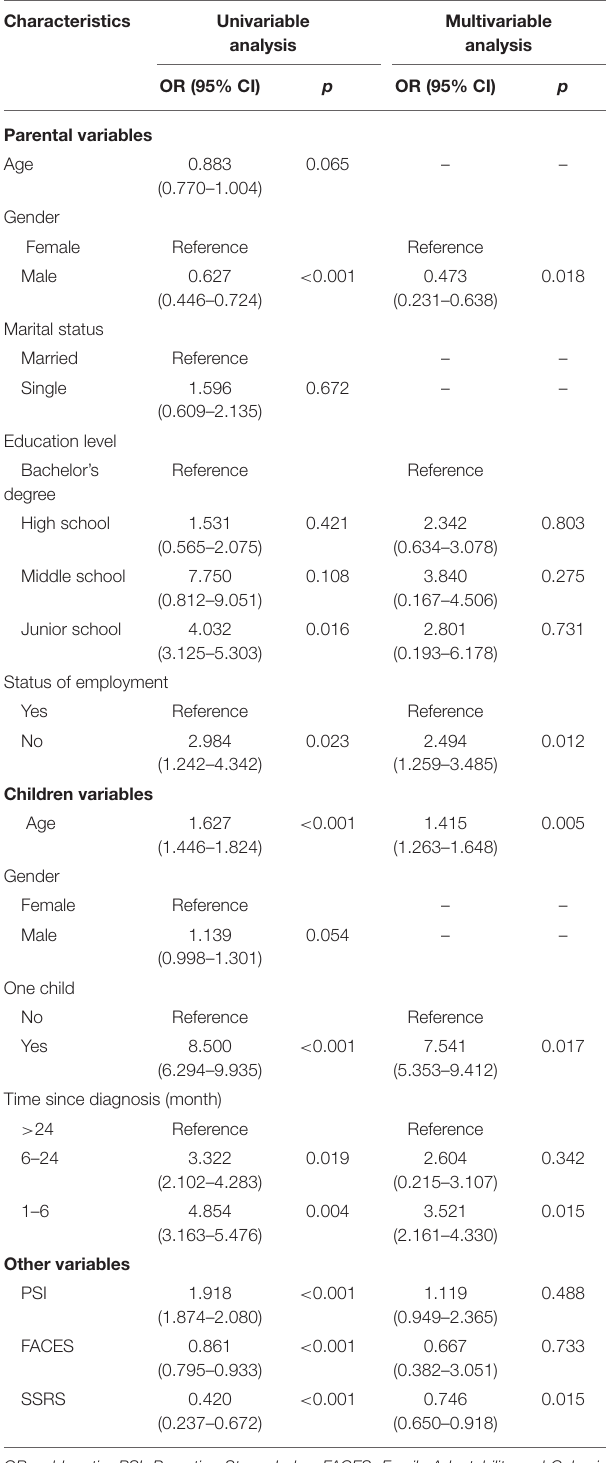
TABLE 2 | Risk factors for unresolved status by univariable and multivariable logistic regression analysis in the modeling dataset.